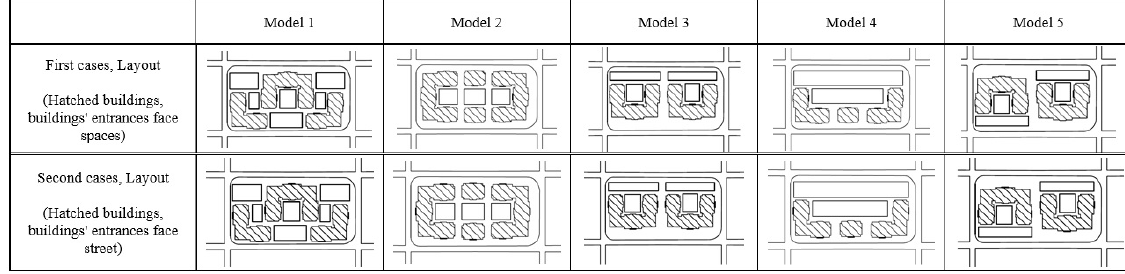
Figure 6. The layouts of tested models